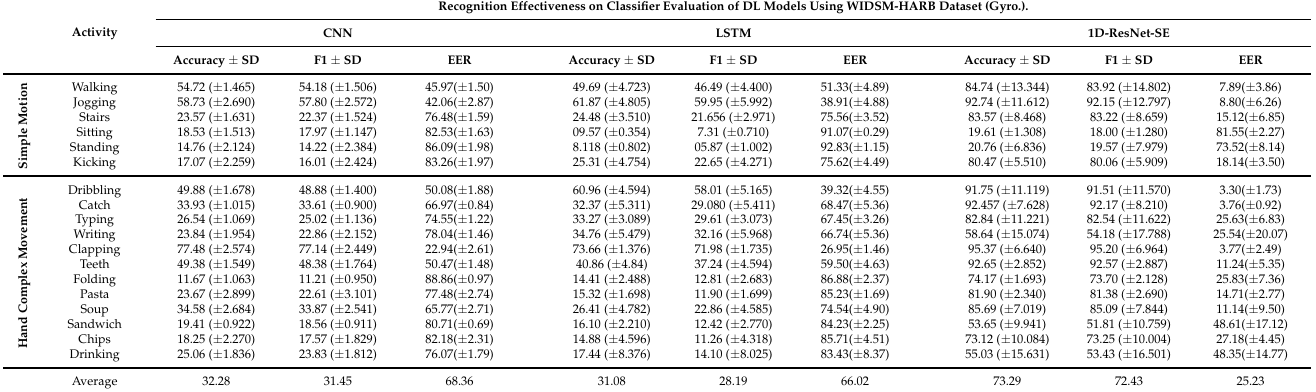
Table 7. Recognition effectiveness on classifier evaluation of deep learning models using WIDSM- HARB dataset. (Gyro.